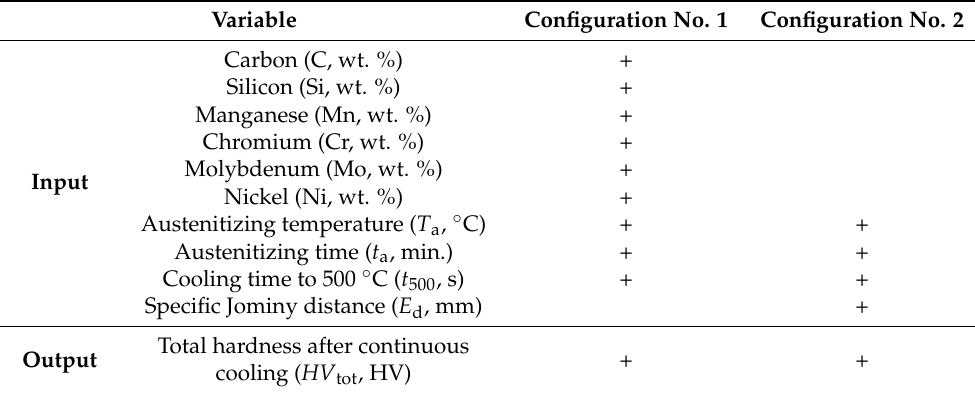
Table 4. Variables used for development of artificial neural networks. Variable Configuration No.